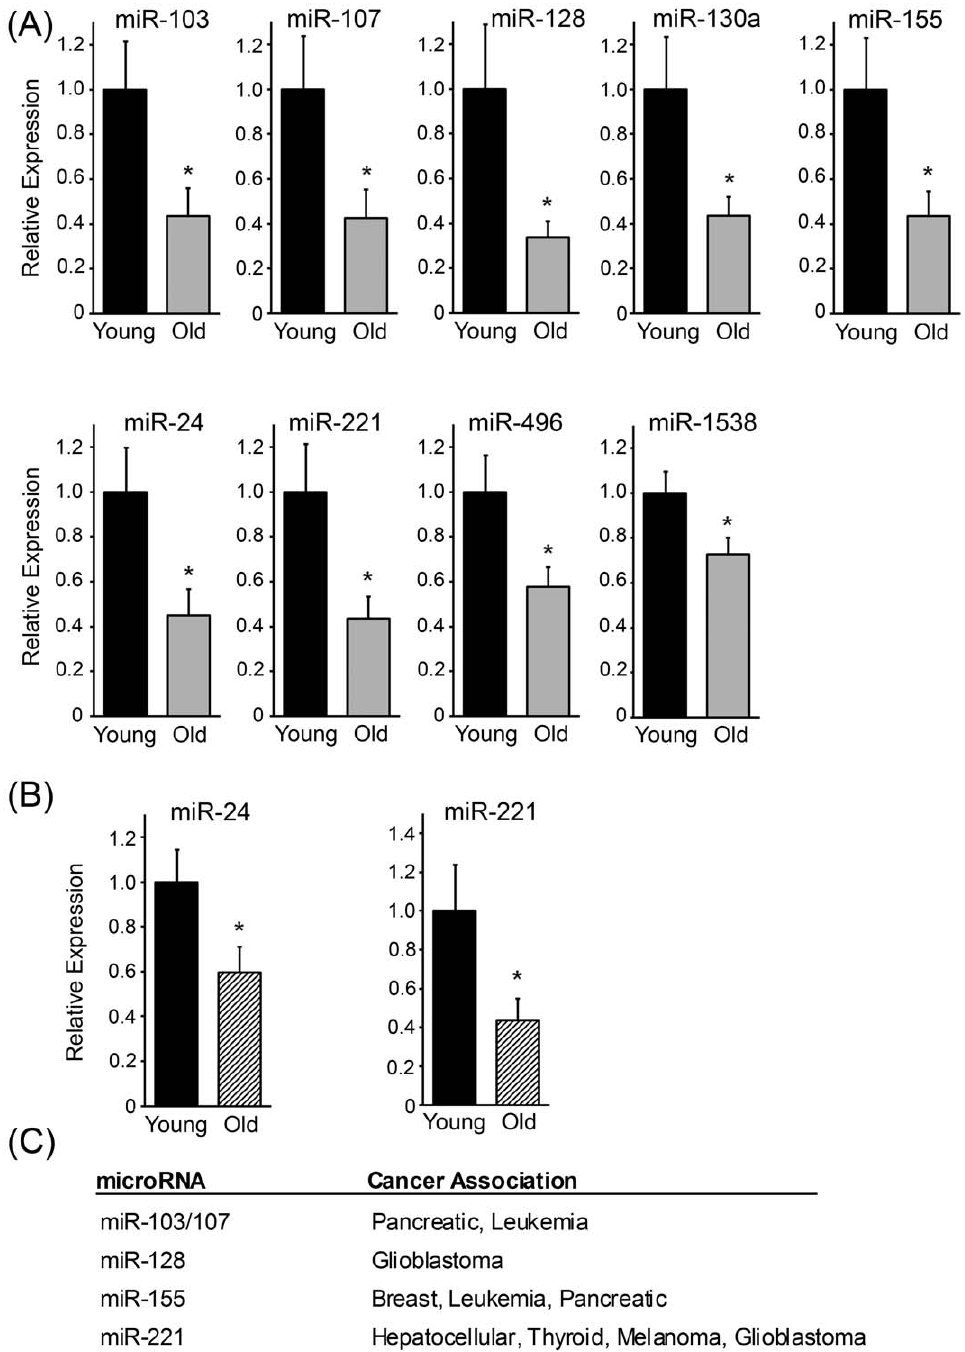
Figure 3. Real-time RT-PCR validation of changes in miRNA expression in young and old participants. (A) Expression of miRNAs from the miRNome analysis were further validated in 14 young and 14 old subject PBMCs (see Table 1B for detailed demographic data) using real-time RT- PCR as described in Materials and Methods. The histograms show normalized averages 6 SEM from duplicate experiments. * P , 0.05 by both Student’s t-test and three-way ANOVA. (B) miR-24 and miR-221 expression was examined in 14 young and 14 old individuals using a TaqMan microarray assay as described in Materials and Methods. (C)Age-associated miRNAs that have been implicated in various cancers. See recent reviews for details [4,35,50].